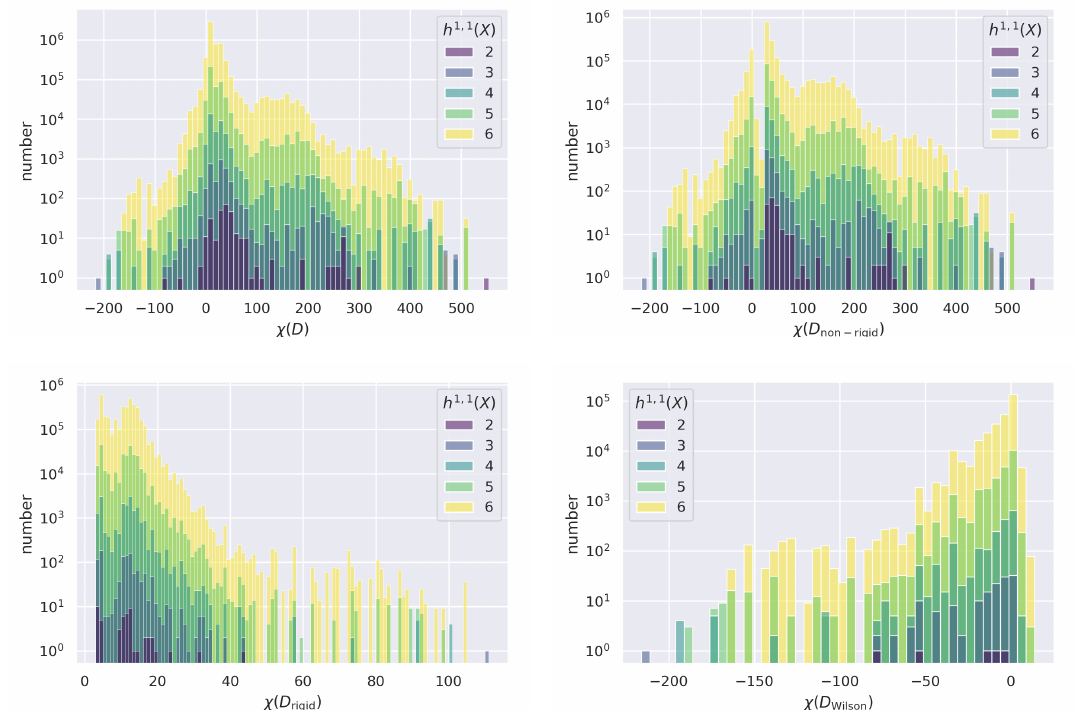
Figure 2 . Histogram plots for Euler numbers of divisors. In the first row, we computed the distribution of Euler numbers for all divisors D on the left and for only non-rigid divisors D either h 0 , 1 ( D ) > 0 or h 0 , 2 ( D ) > 0 . The second row shows the Euler characteristic for divisors which are rigid (left) or Wilson (right) with h 1 , 0 6 = 0 , h 2 , 0 = 0